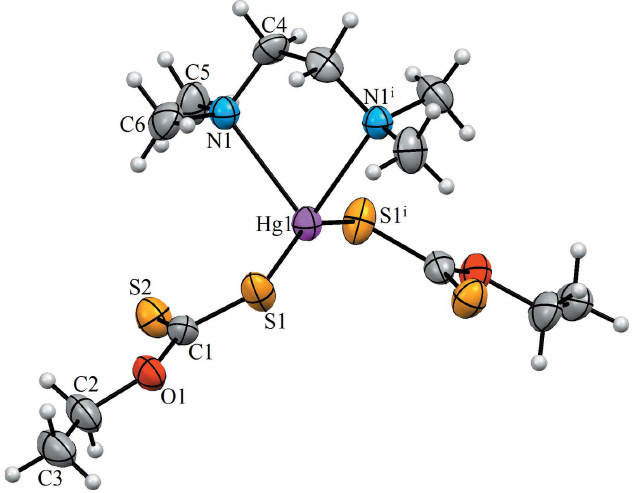
Figure 1 The molecular structure of [Hg(C 3 H 5 S 2 O 1 ) 2 (tmeda)], with the atom labelling. Displacement ellipsoids are drawn at the 30% probability level. Symmetry code: (i) (cid:4) x + 1, y , (cid:4) z + 3